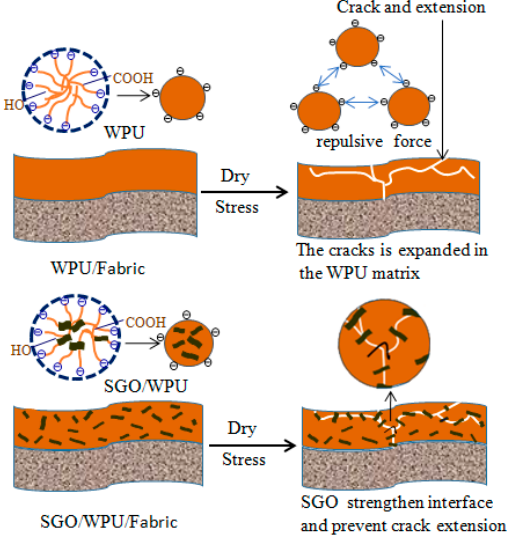
Figure 12. Schematic diagram of SGO enhanced wear-resistant.